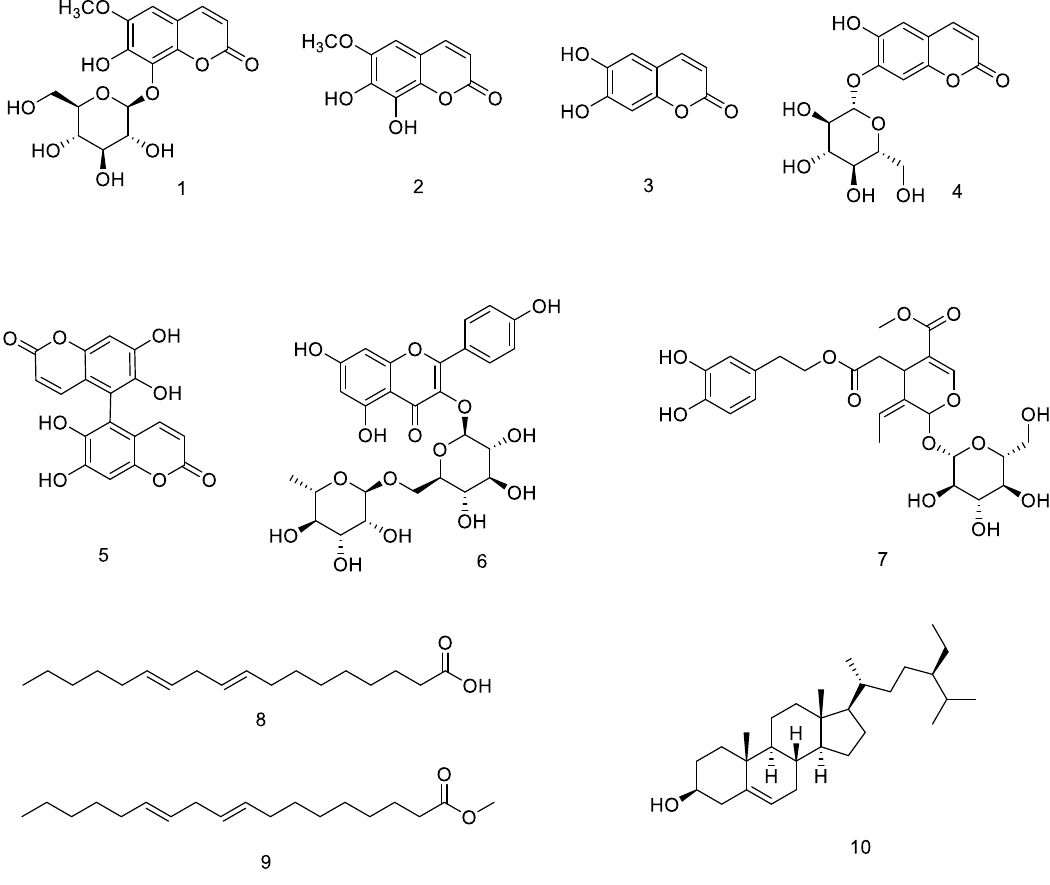
Figure 1. Chemical structures of 1 – 10 isolated from F. hupehensis.